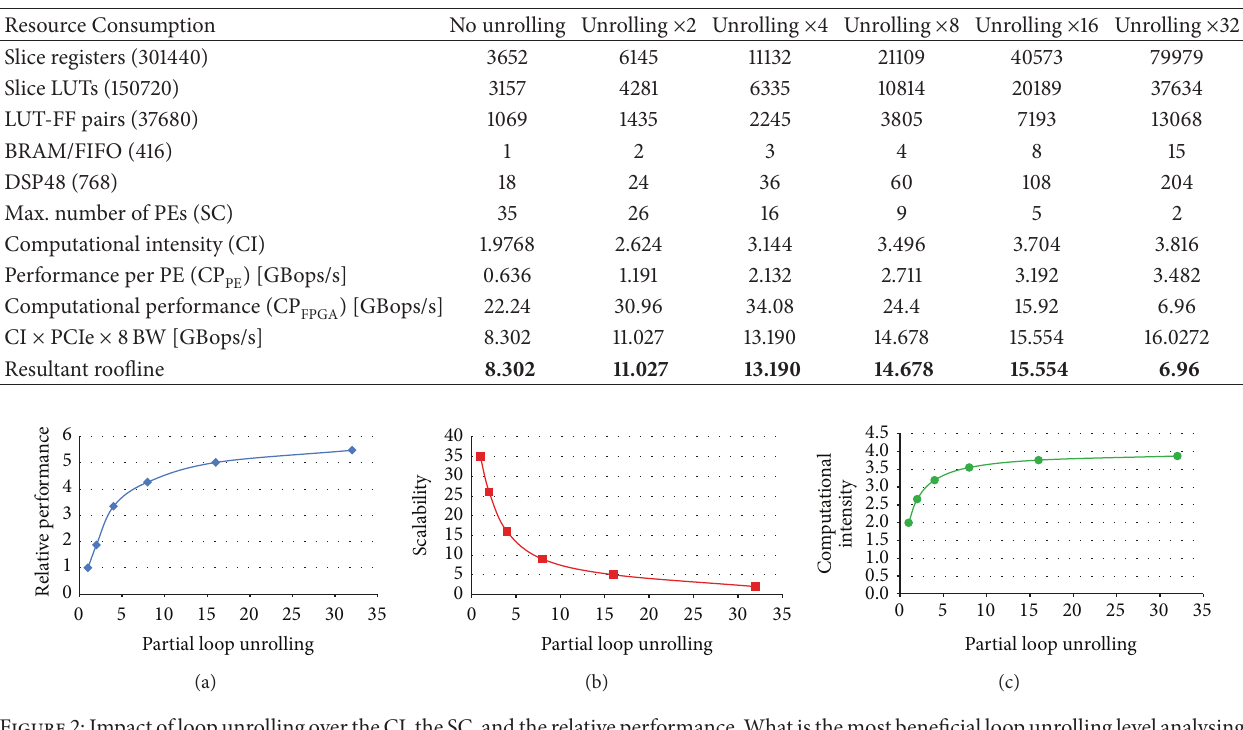
Figure2:ImpactofloopunrollingovertheCI,theSC,andtherelativeperformance.Whatisthemostbeneficialloopunrollinglevelanalysing the values from Table